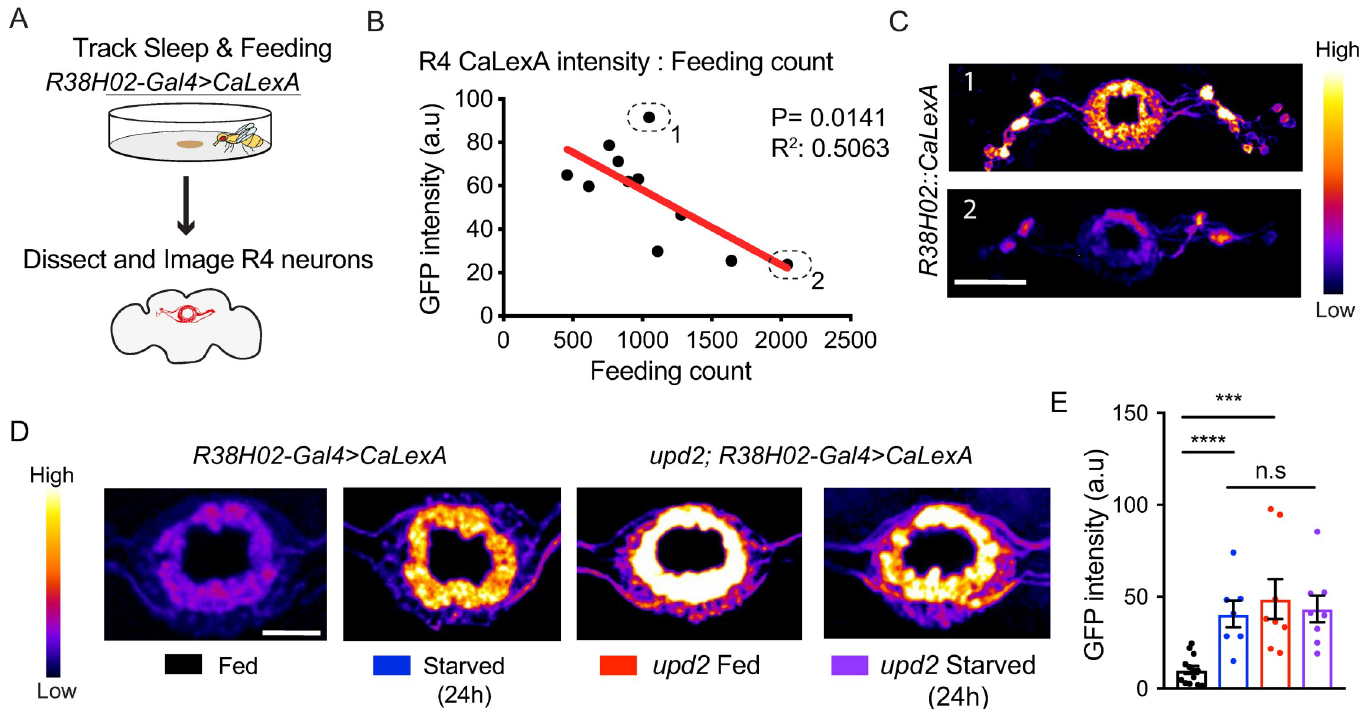
Fig 5. upd2 mutants show increased CaLexA expression in EB R4 neurons. (A) Flies were housed in open-field arenas for 24 hours (starting at ZT0) for tracking sleep and feeding-related behavior. They were then collected for dissection and brains were imaged. (B) Feeding count number in open-field arenas significantly correlated with the measured CaLexA intensity of R4 neurons. (C) Sample images representing a high (number 1, upper panel) compared with a low CalexA signal (number 2, lower panel). n = 11; warmer colors indicate an increase in GFP intensity. (D) Representative whole-mount brain immunostaining of fed (black) and starved wild-type (blue) ( w +; R38H02-GAL4 > CaLexA ) compared with fed (red) and starved upd2 mutant (purple) (genotype: upd2 ; R38H02-GAL4 > CaLexA ). Maximal intensity projections are shown in pseudo color (scale bar = 20 μ m). (E) Quantification of CaLexA signals ( n = 8–13 per condition). Control flies had ad libitum access to food from days 0 to 6. Starved group was transferred to 1% agar/starvation medium on day 5 (ZT0) until day 6 (ZT0). For correlation analysis, two-tailed P values for Pearson’s correlation coefficient are shown. Student t test for normally distributed data or Mann-Whitney U rank-sum test for nonparametric data was used to compare data sets. � P < 0.05, �� P < 0.01, ��� P < 0.001; error bars show SEM. Flies in B and E were from a different antibody cohort. The data underlying this figure can be found in S1 Data. CaLexA, calcium-dependent nuclear import of LexA; EB, ellipsoid body; GFP, green fluorescent protein; upd2 , unpaired 2.